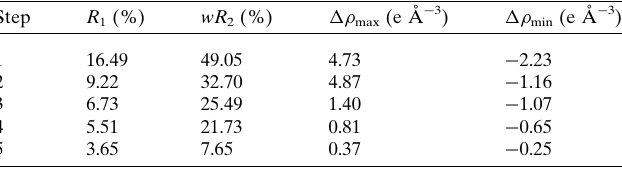
Table 3 Statistics for intermediate and final model building and refinement stages.